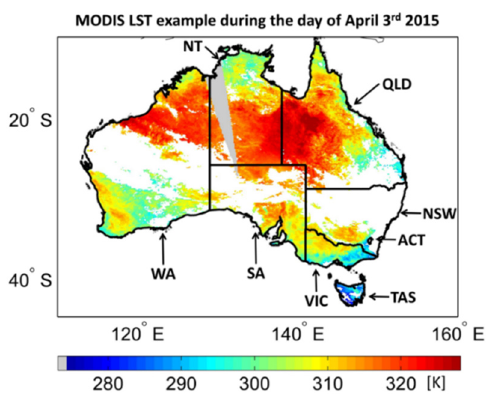
Figure 1. An example of the MODIS Land Surface Temperature product on 3 April 2015 (01:30 PM) that demonstrates cloud obstruction (e.g., WA, SA, NSW and ACT) which affects the availability of this Land Surface Temperature product. Note that the gray shading is an area that was not observed by the MODIS sensor on that particular day. Also, this figure presents the abbreviations for the Australian states that will be further used for reference purposes.